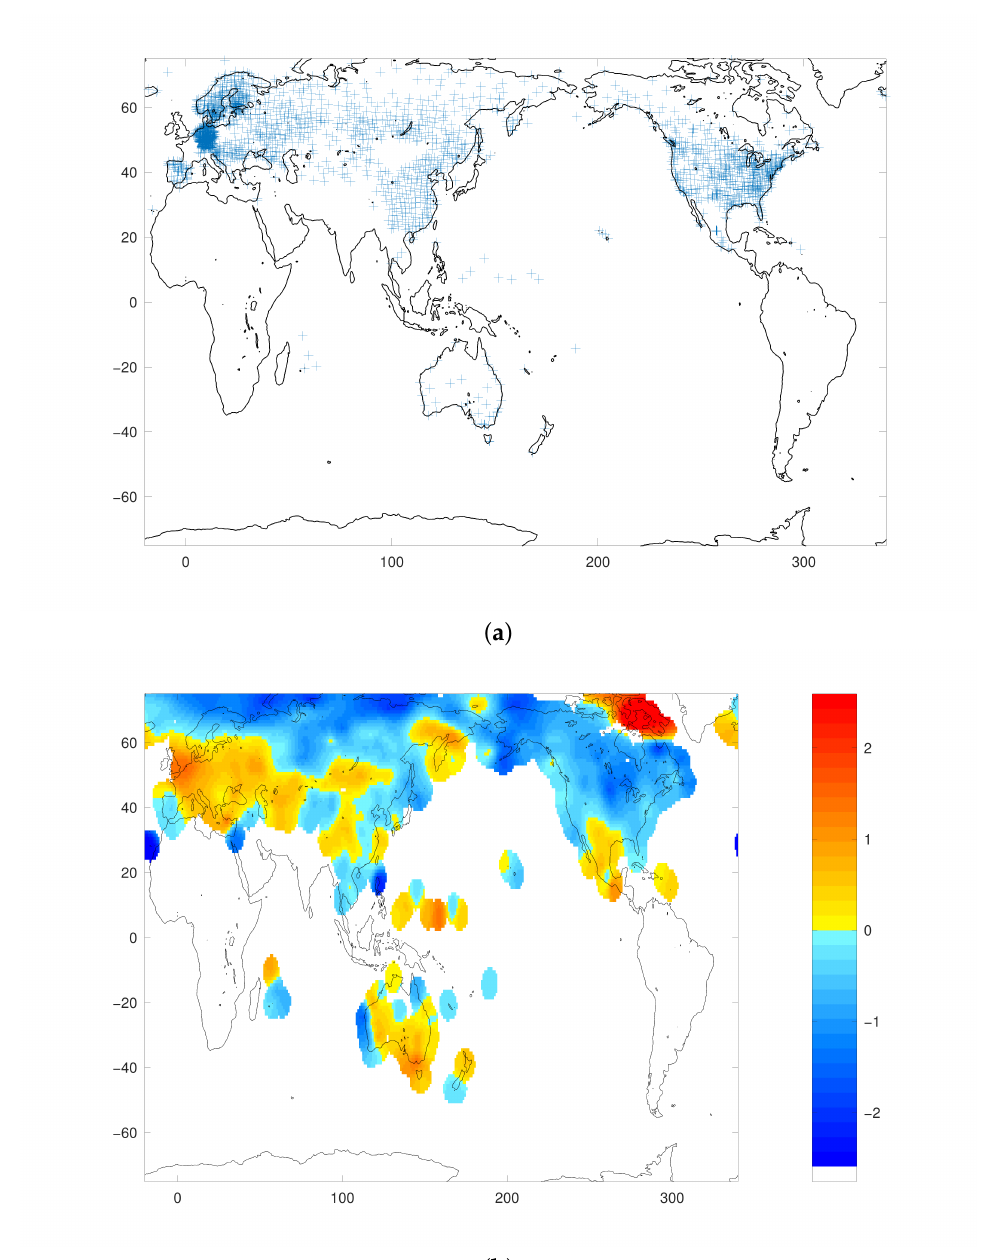
Figure 4. ( a ) Locations of GHCN-D stations available to compare with ERA5. ( b ) Change in the difference between TXx and T 80 max ( ◦ C), 1959–2021, based on spatial interpolation of GHCN-D stations. In the interpolation scheme, station values were weighted based on distance to each interpolation point with an exponential decay length scale of 2 ◦ . Interpolation was not performed for grid points over 4 ◦ away from a GHCN-D